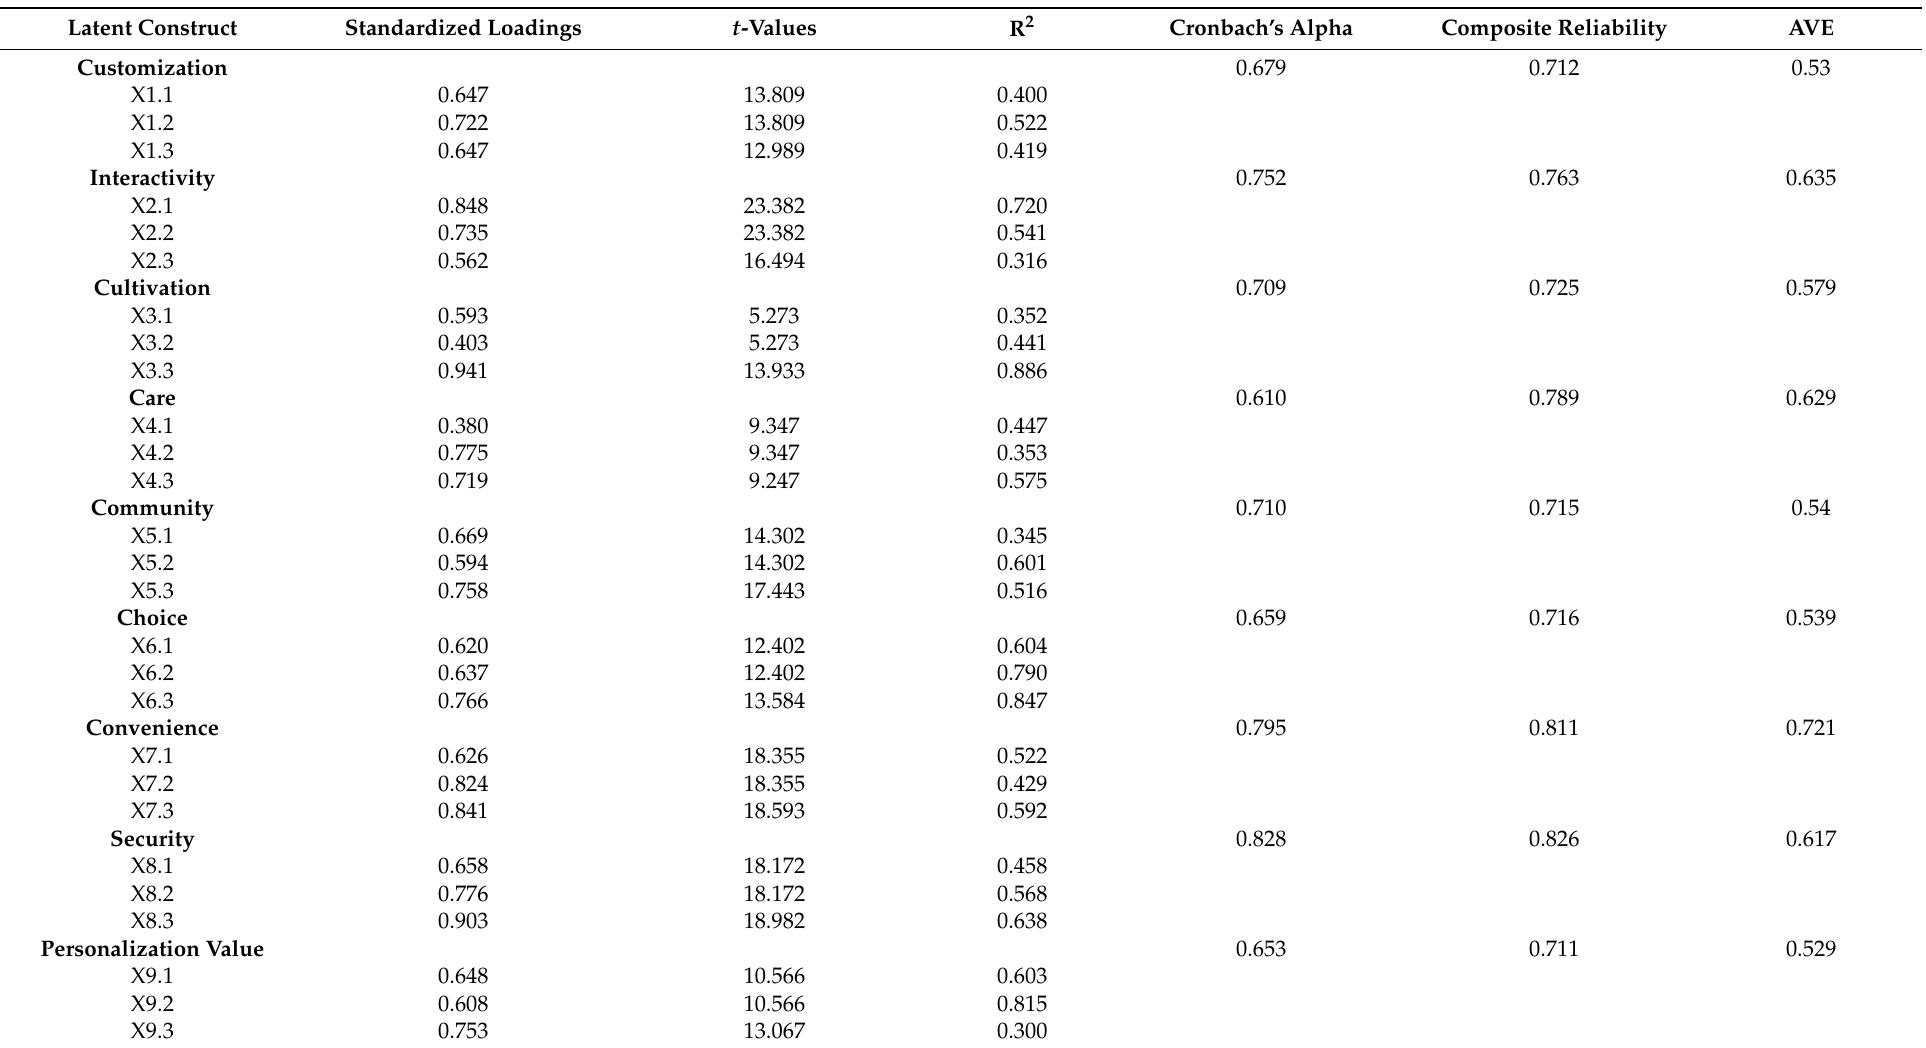
Table A4. Confirmatory Factor Analysis (CFA)